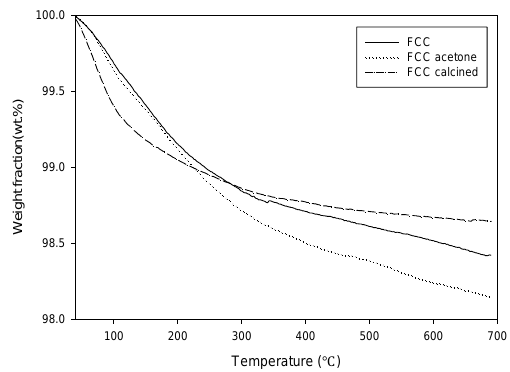
Figure 1. Thermo-gravimetric analysis (TGA) curves of catalysts.